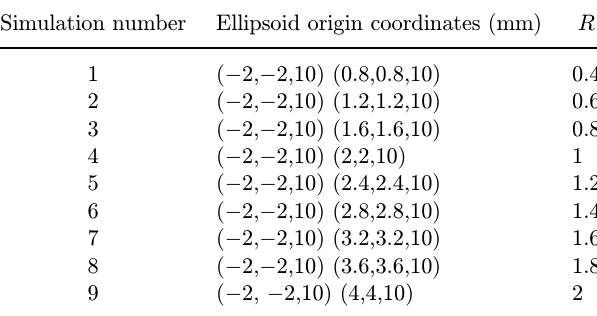
Table 3. Experiment parameter of the two °uorescent